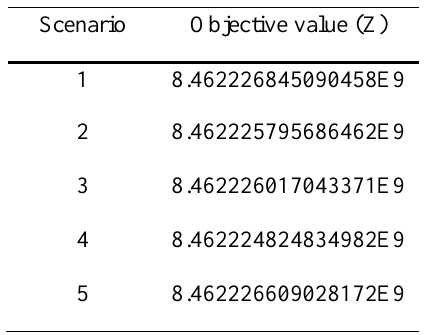
Table 5. Calculated single-objective values for different